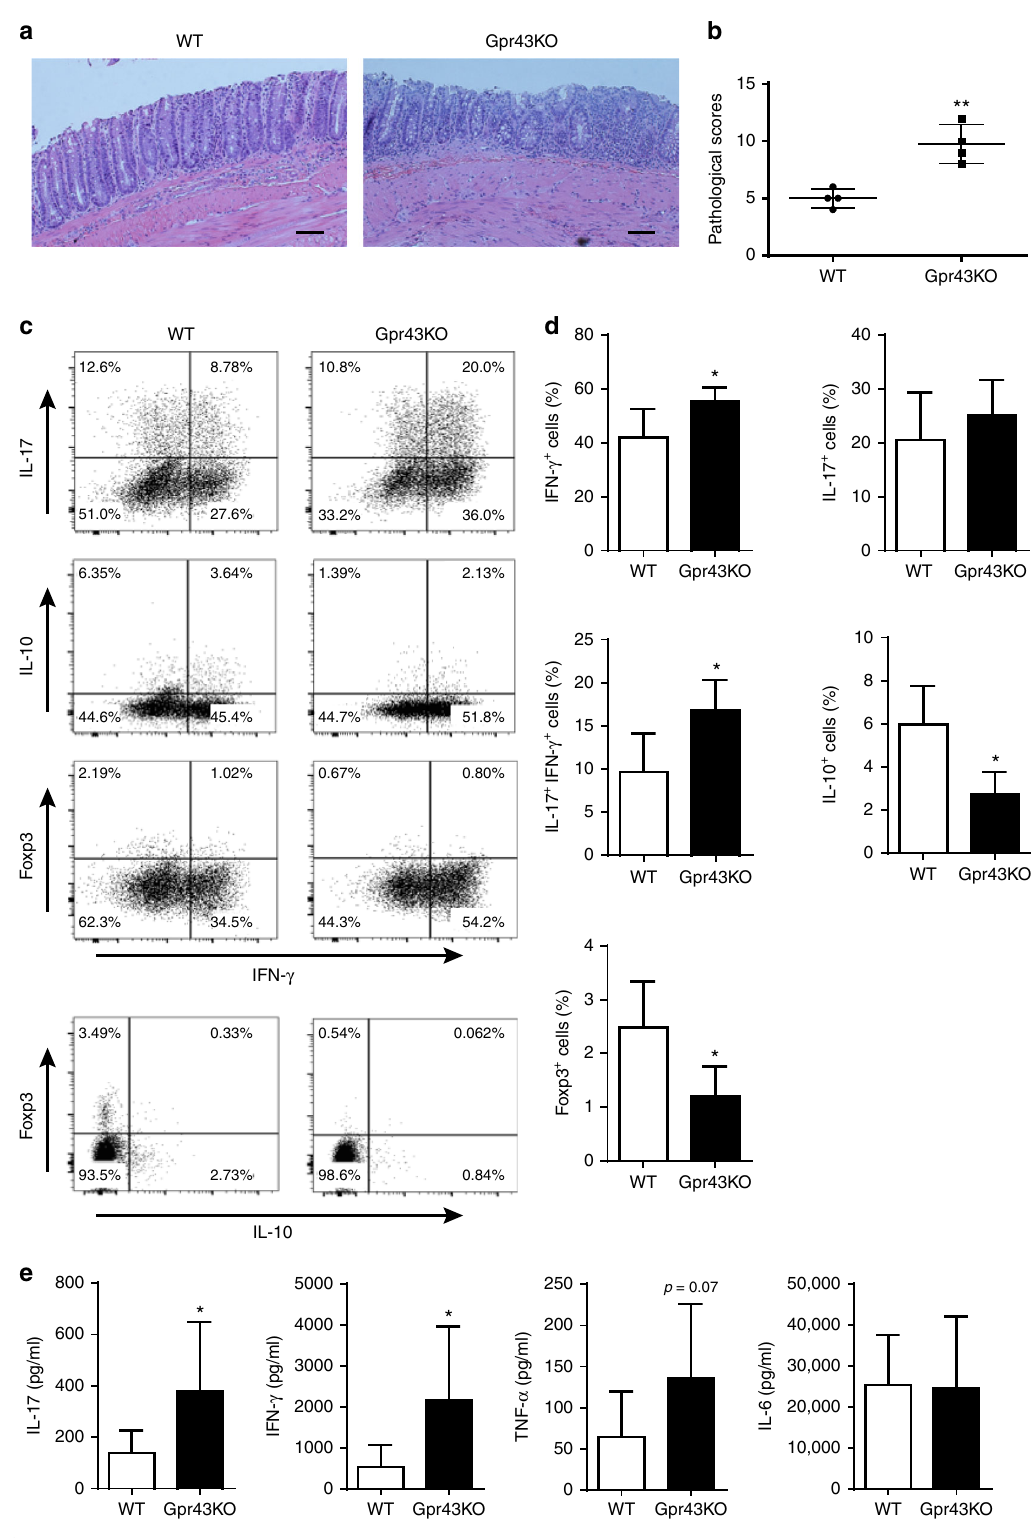
Fig. 1 Gpr43 − / − microbiota antigen-speci fi c Th1 cells increase pathological potency in induction of colitis. 1 × 10 6 WT CBir1 (WT) and Gpr43 − / – CBir1 (Gpr43KO) Tg Th1 cells were injected i.v. into groups of Rag − / – mice ( n = 4/group). Six weeks post-T-cell transfer, the severity of intestinal in fl ammation was assessed. a , b Colonic histopathology ( a ) and histological scores ( b ) are shown. Scale bar, 100 μ m. ** p < 0.01 Mann – Whitney U -test. c LP CD4 + T-cell cytokine production and Foxp3 expression were determined by fl ow cytometry. Plot numbers represent the percentage of CD4 + T-cells in the respective quadrants. d Bar charts of the percentage of cytokine-expressing CD4 + T-cells. e Colonic tissues were cultured in the medium for 24 h, and the supernatants were collected for ELISA assay of IL-17, IFN- γ , TNF α , and IL-6. Data are shown as mean ± SD of one representative of three experiments. * p